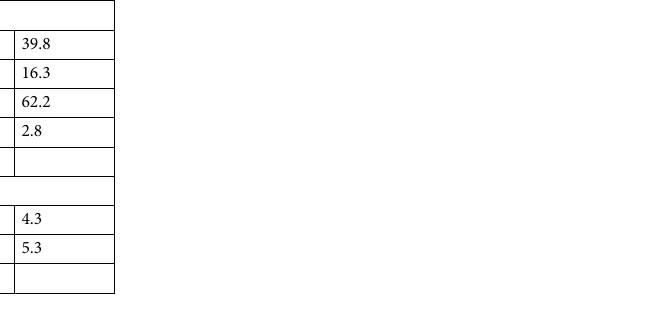
Table 1. Comparison with previous